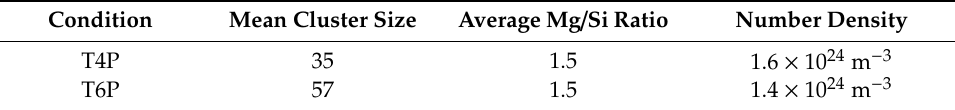
Table 5 . Properties of the Mg–Si clusters of Alloy Zn + Sn in the T4P and T6P condition.